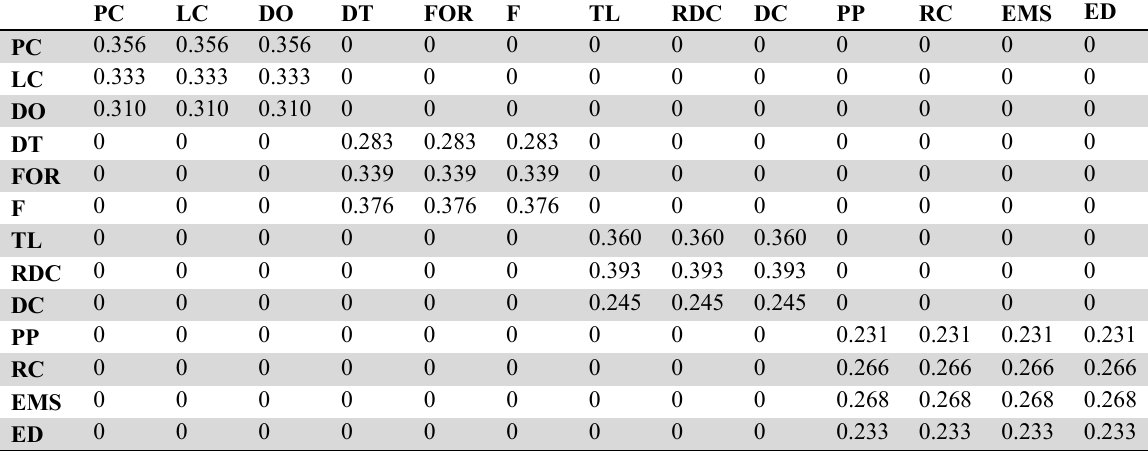
Independence index for sub-criteria of the supplier selection model